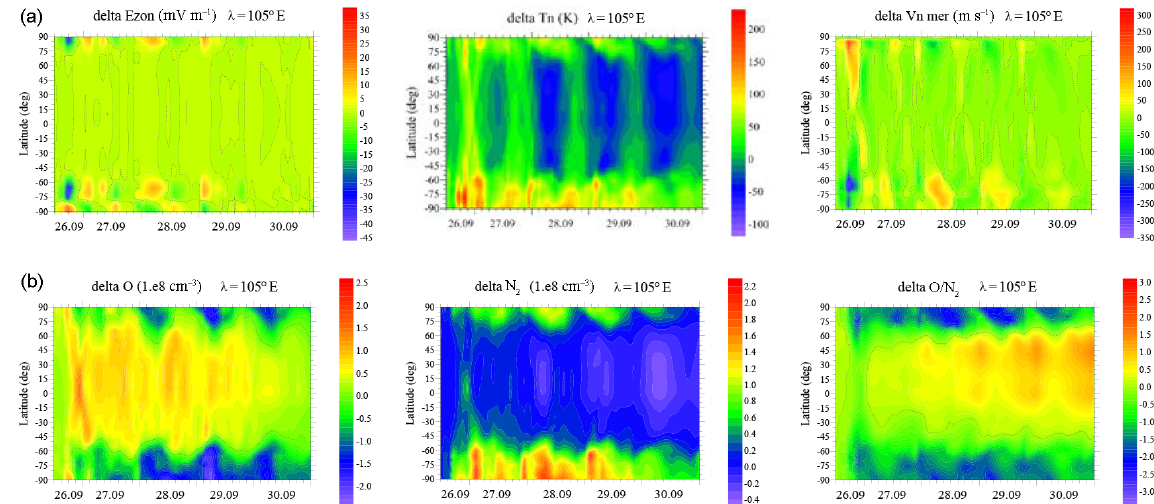
Figure 5. Behavior of the GSM TIP model-derived disturbances in zonal electric field, neutral temperature and meridional velocity of the thermospheric wind (a) , n (O), n (N 2 ) and n (O) /n (N 2 ) (b) at the height of 300km during geomagnetic storms on 26–30 September 2011 at the longitude of 105 ◦ E.